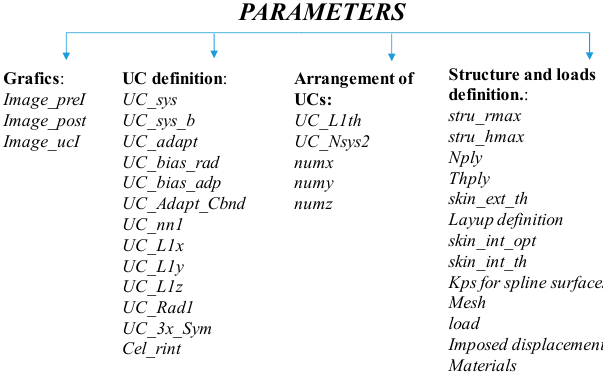
Figure 1. Classification of the parameters used in the routine.